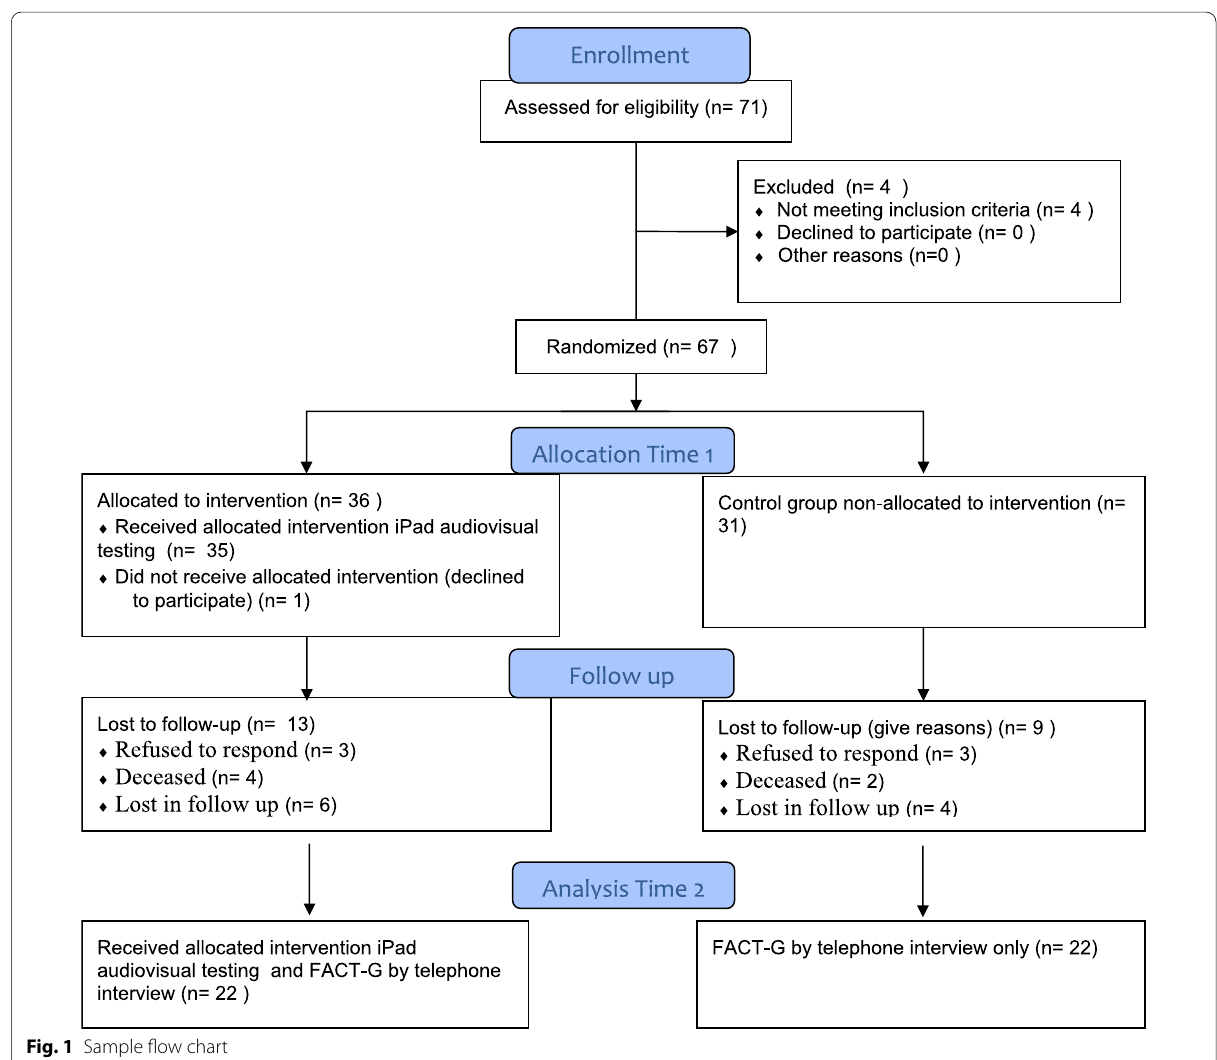
Fig. 1 Sample flow